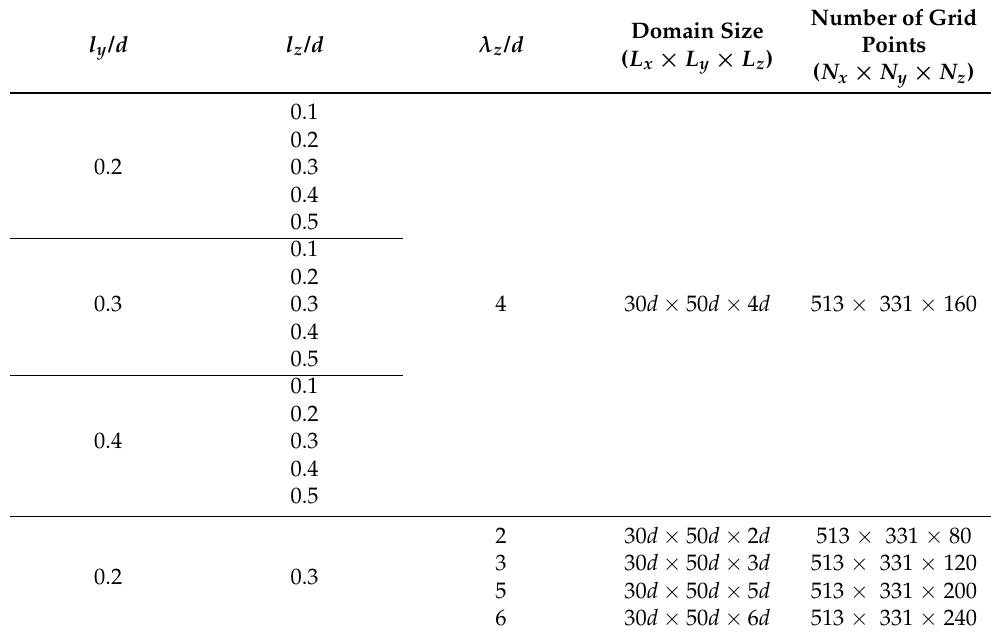
Table 1. Geometric parameters of the tabs, computational domain sizes, and numbers of grid